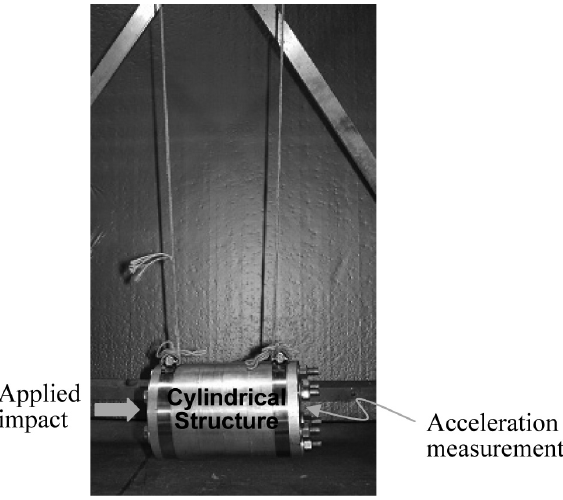
Fig. 1. Experimental setup showing a short cylindrical